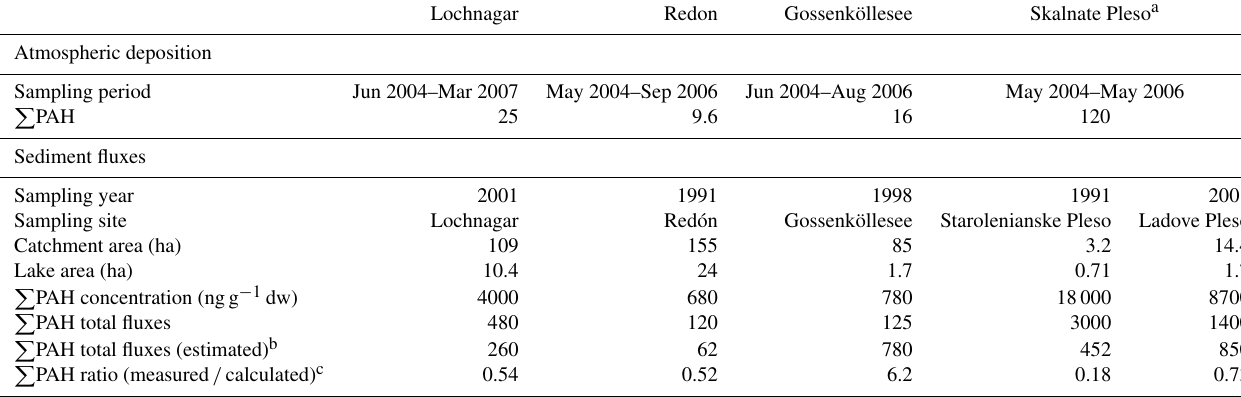
Table 6. Comparison between atmospheric deposition and lacustrine sediment fluxes of PAHs in the study regions (µgm − 2 yr − 1 ). Lochnagar